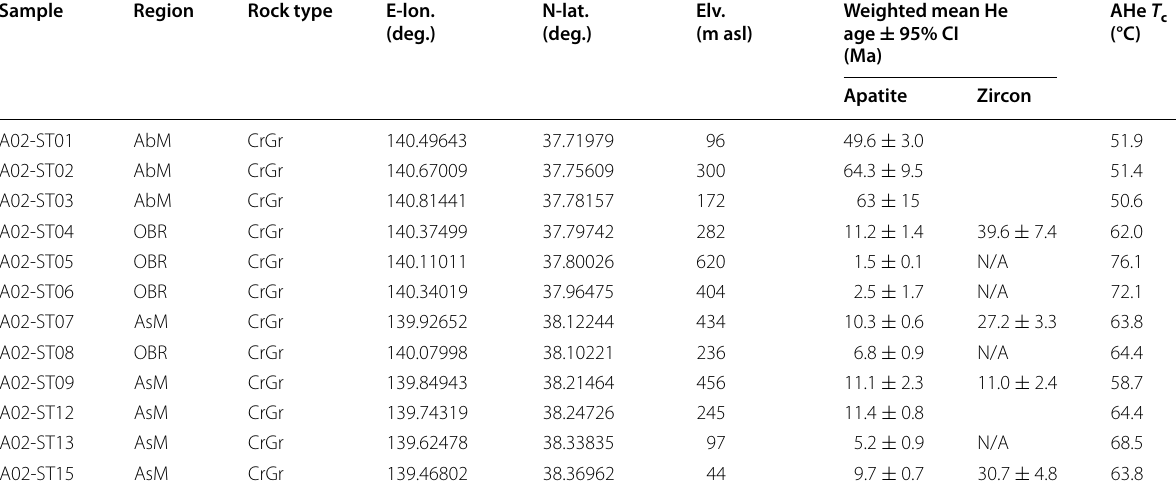
He ages are shown as weighted mean (see also Tables 2, 3). N/A denotes that weighted mean ages were not adopted. AHe T c is the closure temperature of the AHe system considering the cooling rate of each sample; detailed calculations are shown in the body text AbM Abukuma Mountains, OBR Ou Backbone Range, AsM Asahi Mountains, CrGr Cretaceous granitoid